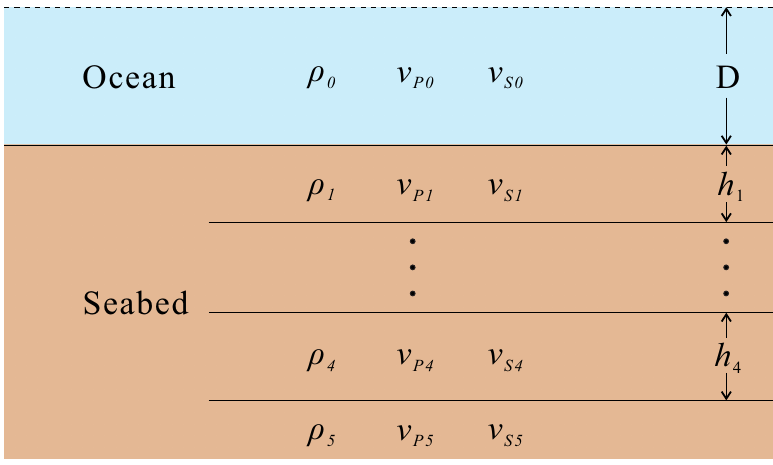
Figure 8. Geoacoustic model used in the inversion.